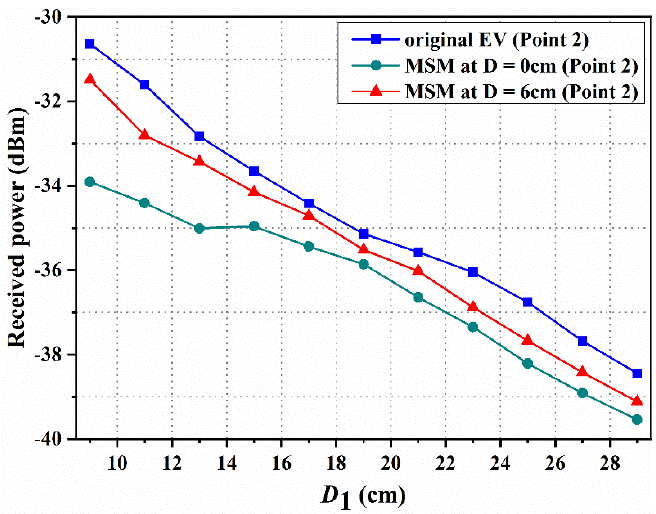
Figure 10. Measured magnetic field at point 2 when the distances from the Rx coil are 0 and 6 cm. Figure 11 shows the magnetic field versus various measured distances at point 3. The MSM is placed on the side of the EV system. The results confirm that the magnetic field is decreased when the MSM is applied in the EV system. The magnetic field is reduced by − 4.69 dBm at point 3, which is 5 cm away from the MSM. As a result, the experimental results indicate that the MSM can significantly decrease the magnetic field when it is used in EV wireless charging, including the EV-WPT system ’ s top and side positions.